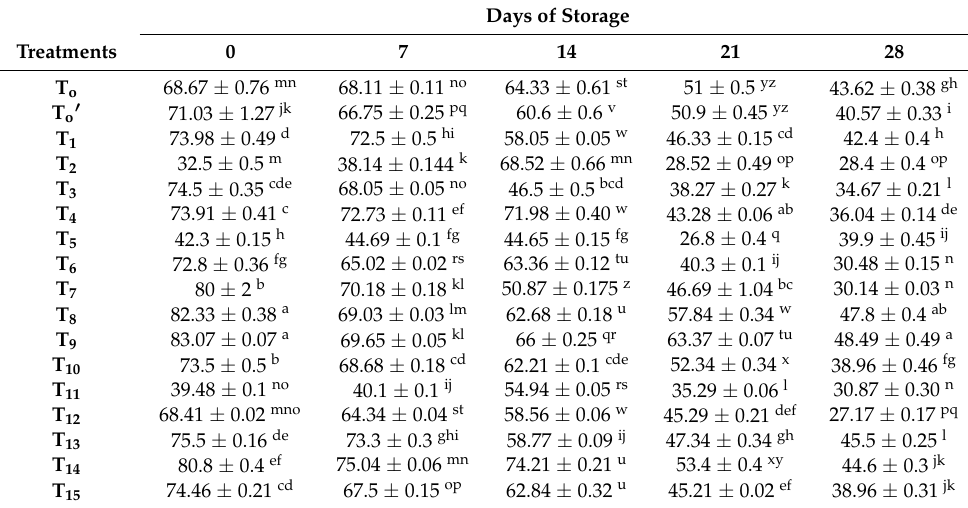
Table 7. Effect of guar gum and storage time on the water-holding capacity (%) of probiotic yoghurt. Days of